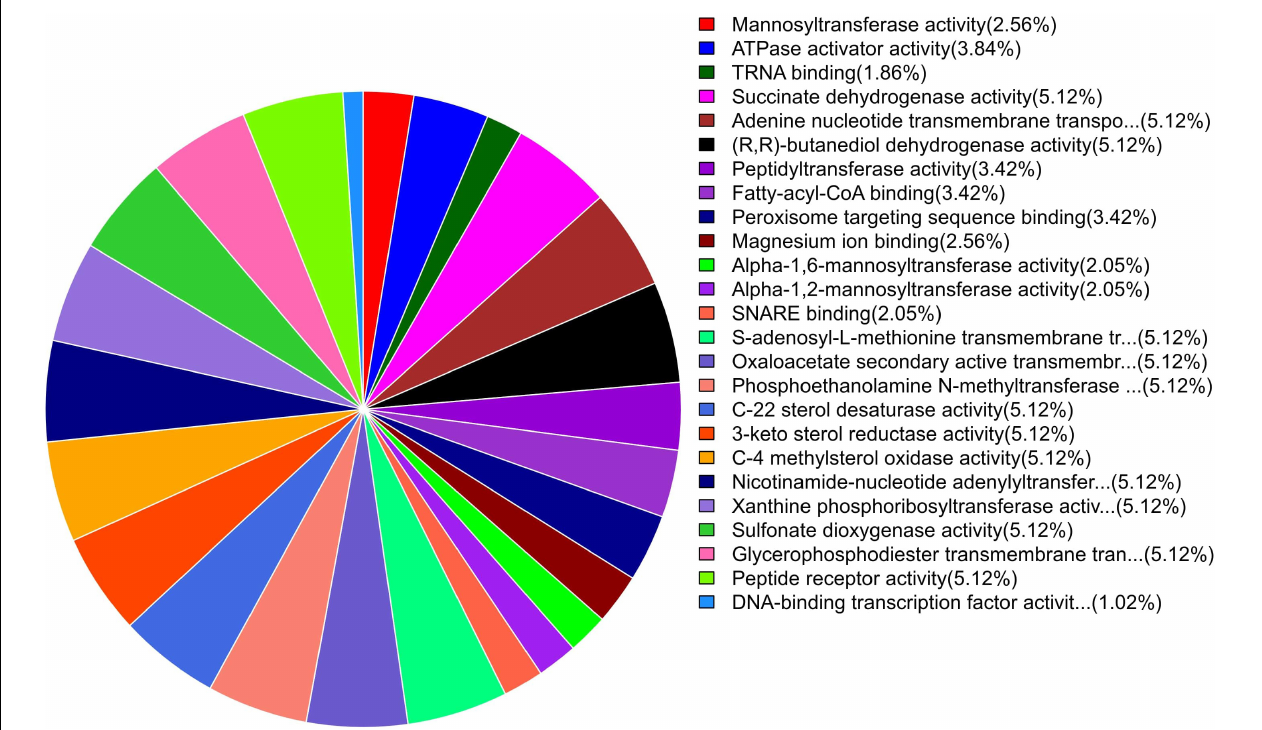
FIGURE 6 | Pie chart of enriched GO terms of B. maydis for molecular functions differentially expressed in inoculated resistant and susceptible plants.